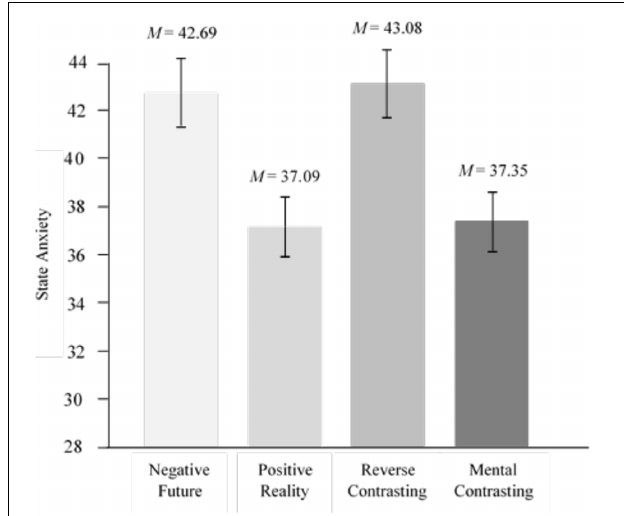
FIGURE 1 | Effects of self-regulatory strategies on state anxiety vis-à-vis the fear of a future E. coli epidemic. Error bars represent standard errors. Covariates appearing in the model are evaluated at the following values: Trait anxiety, M = 37.92; baseline state anxiety, M = 5.40; expectations, M = 5.86; and incentive value, M =